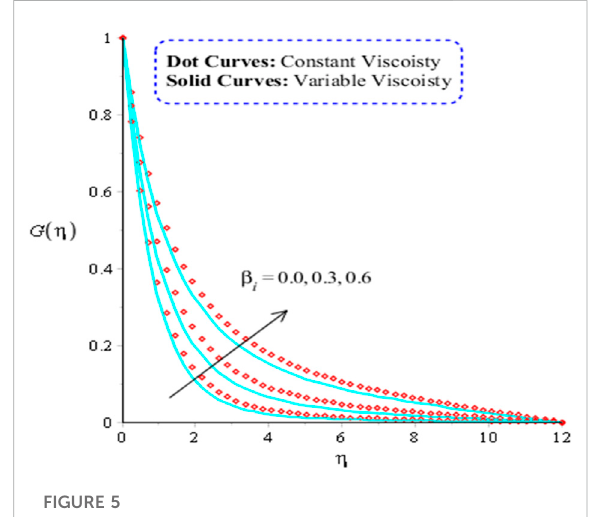
FIGURE 3 Variation in secondary velocity fi eld versus We .